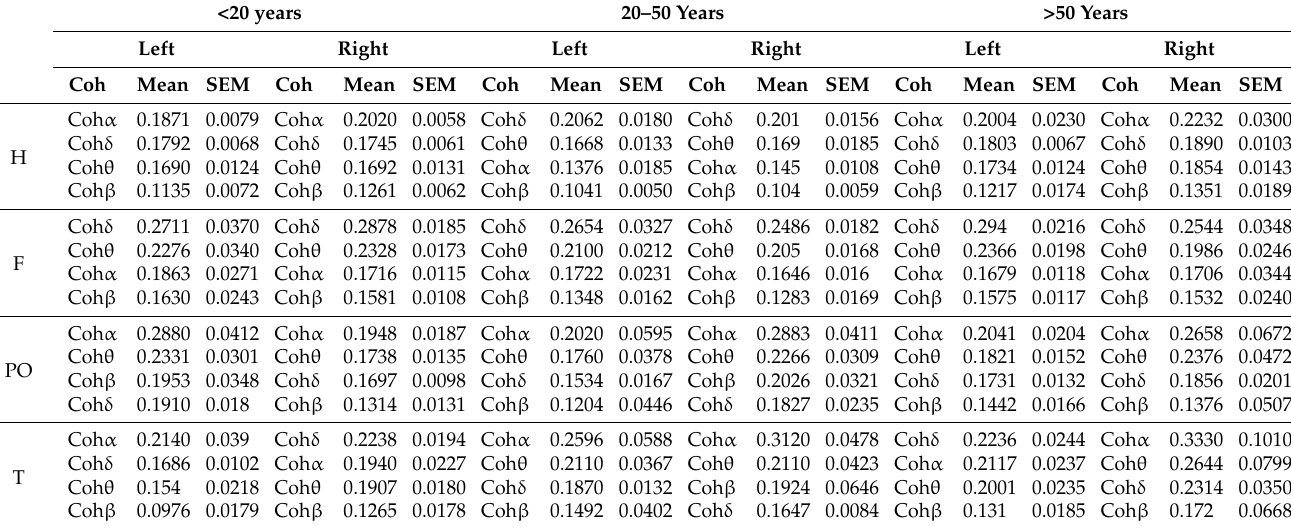
Table 3. Structure of the synchronization of different lobes as function of age. Data are ordered from the highest to lowest values of different measurements of synchronization (Coh) lobe; therefore, the column Coh do not follow the same